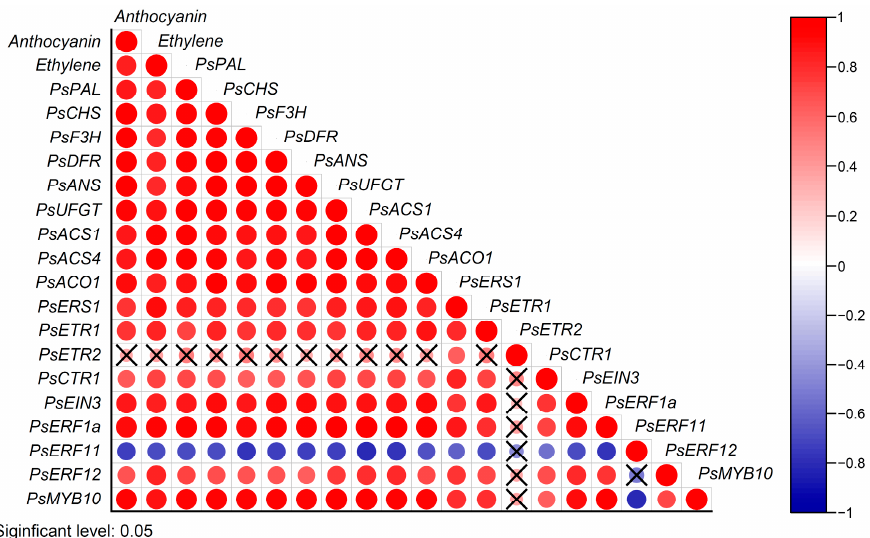
Figure 8. Correlation analysis among ethylene production rate, anthocyanin content, expression of genes associated with ethylene signal pathway and anthocyanin biosynthesis. n = 21, × represents no significant correlation between the two sets of data.